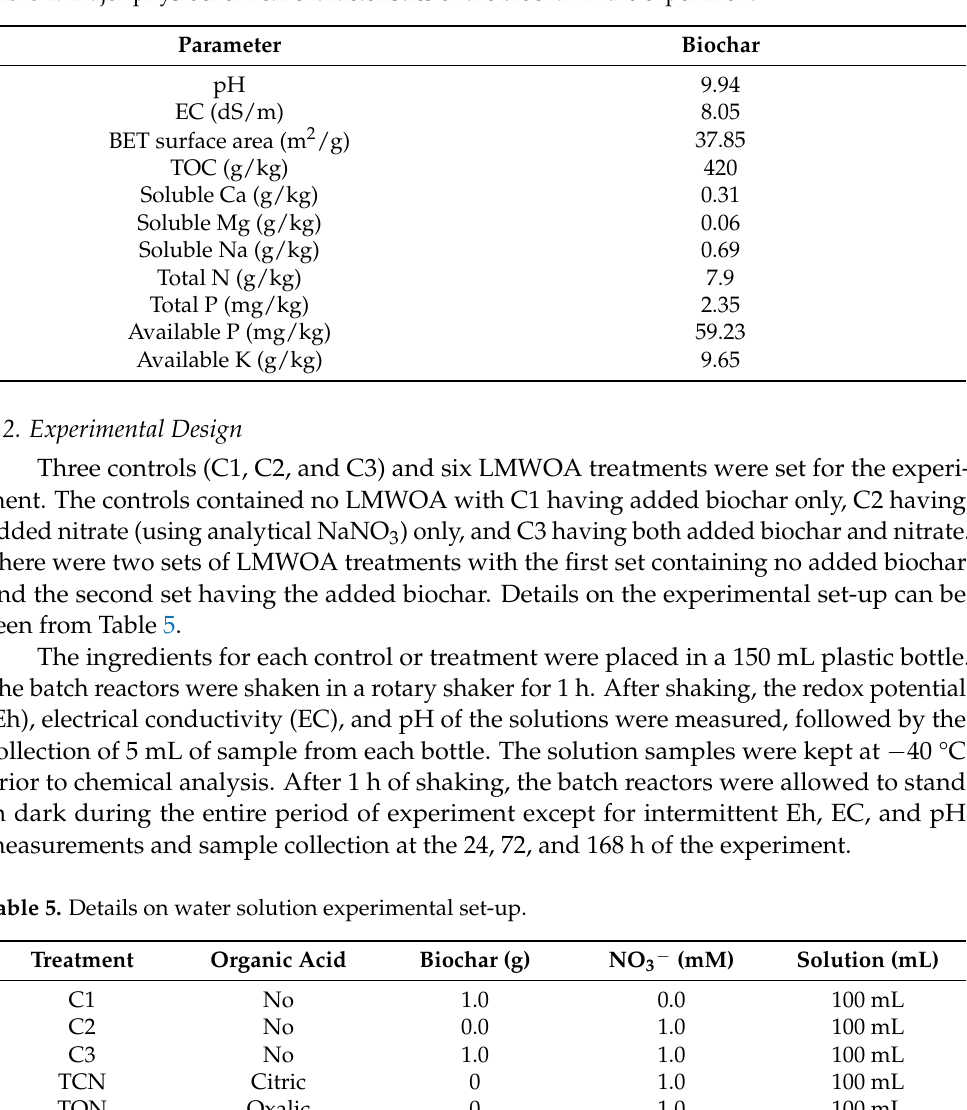
Table 4. Major physiochemical characteristics of the biochar in the experiment.